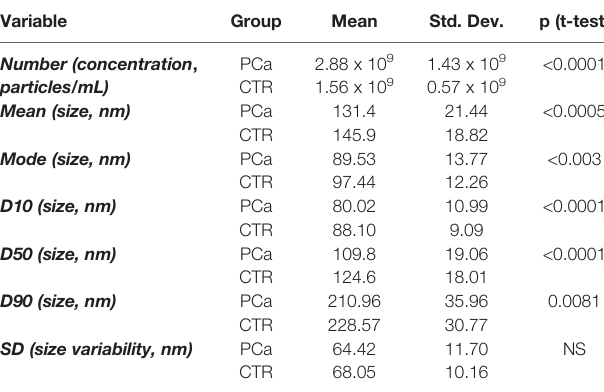
TABLE 1 | Descriptive and inferential statistics or the two patient groups (PCa = Prostate Cancer, CTR = individuals with no signs of urological disease) as for the entire set of NTA derived